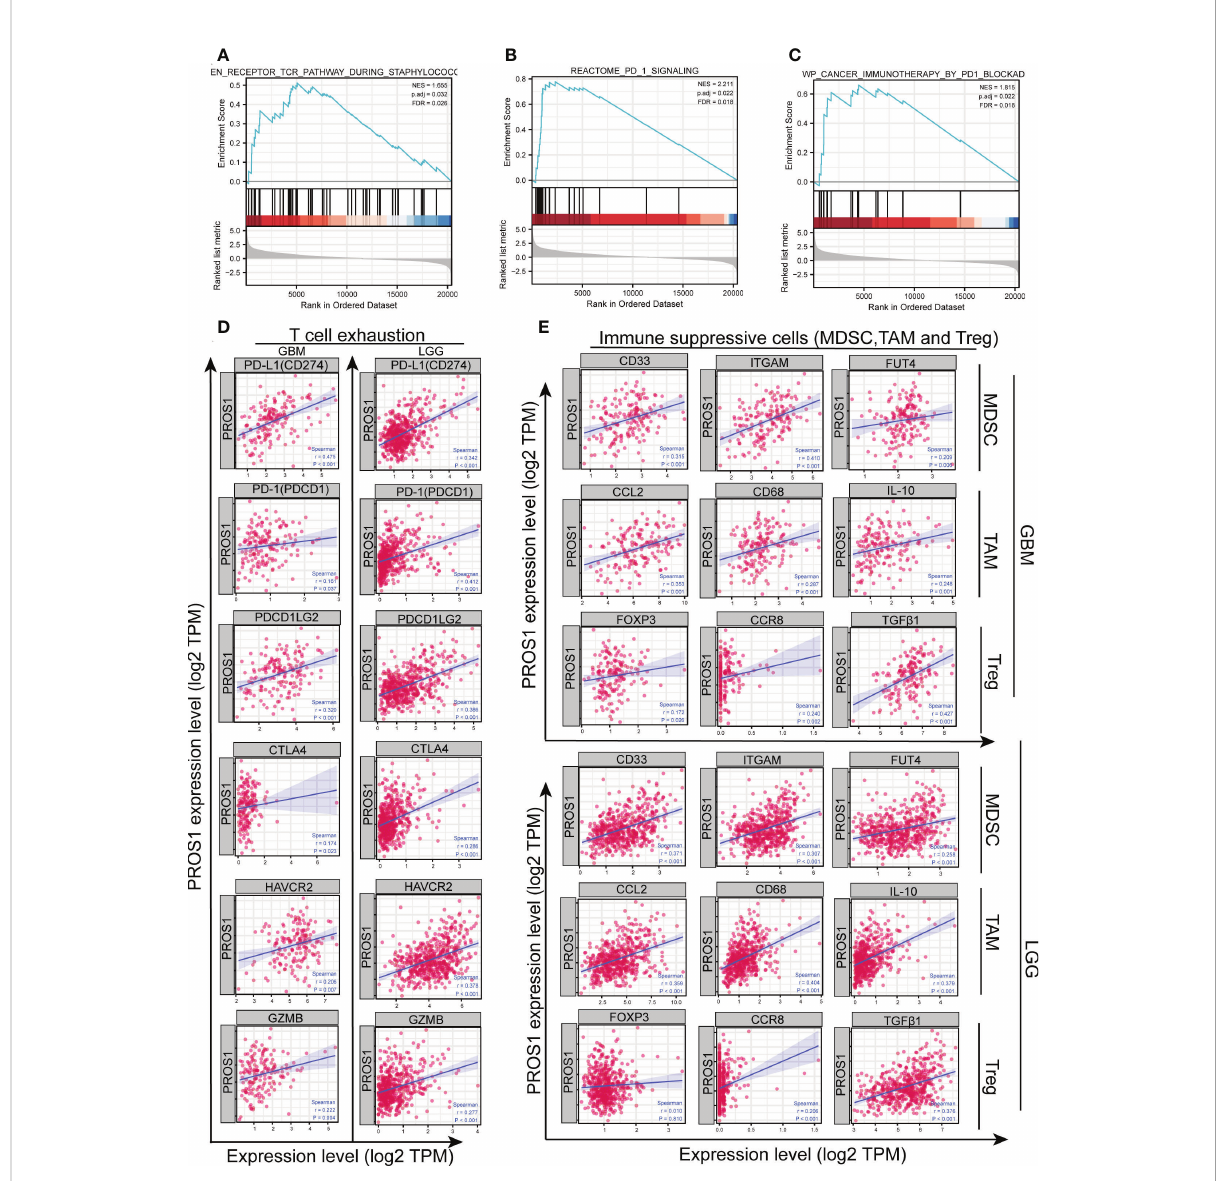
FIGURE 6 PROS1 expression is signi fi cantly correlated with the markers of immunosuppressive molecules in glioma. Enrichment plots from gene set enrichment analysis (GSEA) showed the high expression of PROS1 associated with (A) T cell antigen receptor pathway, (B) PD-1 signaling pathway, and (C) immunotherapy by PD1 blockade. (D) The Spearman correlation analysis revealed that the expression of PROS1 was correlated with the T cell exhaustion, including PD-L1, PD-1, PDCD1LG2, CTLA4, HAVCR2, and GZMB in glioma (all P < 0.05). (E) The Spearman correlation analysis results suggested the immune marker sets of MDSC (CD33, ITGAM, FUT4), TAM (CCL2, CD68, IL-10) and, Treg (FOXP3, CCR8, TGF b 1) were associated with the PROS1 expression in